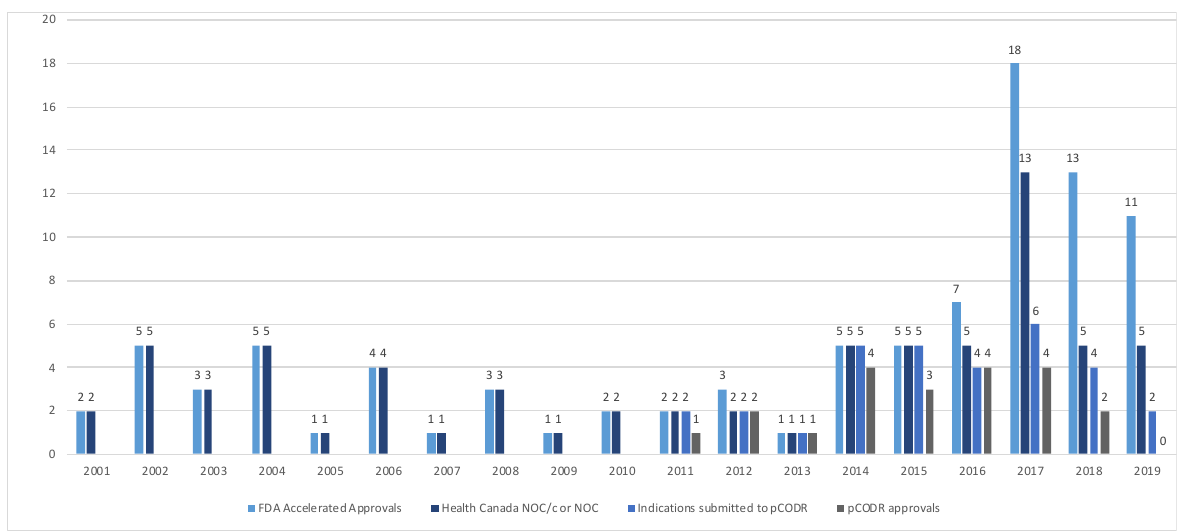
Figure 2. Accelerated approvals, notice of compliance issued and pCODR approvals over time from 2001–2019. (FDA—Food and Drug Administration, NOC/c—notice of compliance conditional, NOC—notice of compliance, pCODR—pan-Canadian Oncology Drug Review).